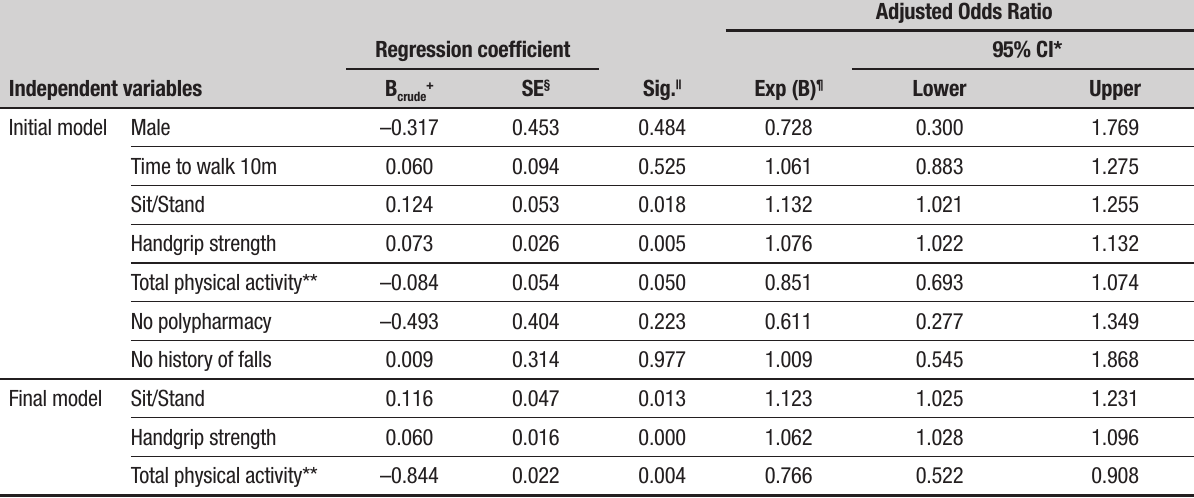
Table 4. Multivariate Binary Logistic Regression Models for prediction of satisfaction with body image.